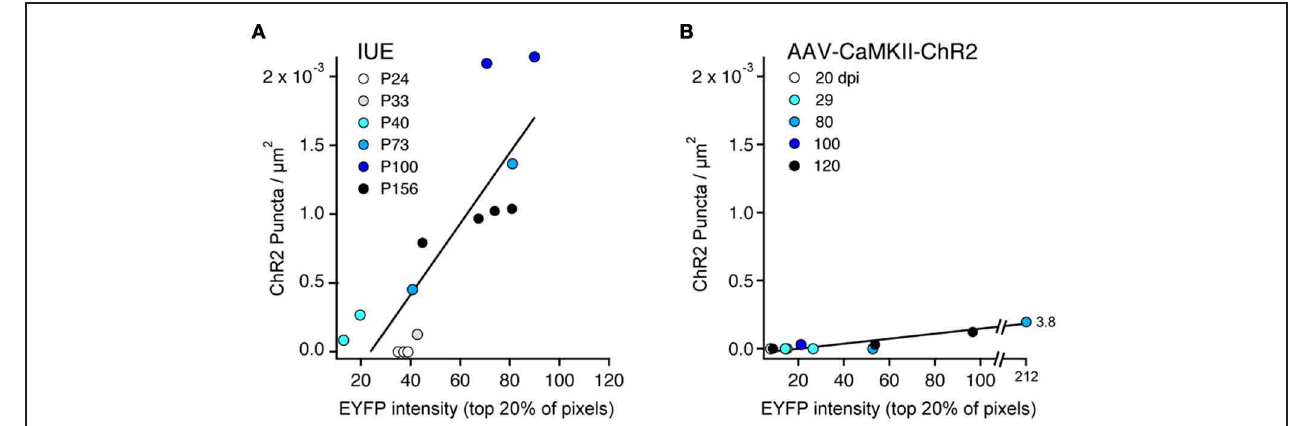
FIGURE 8 | ChR2 puncta density correlates with ChR2 expression level. (A) , IUE cases. Each point represents one animal, analyzed in L2/3 at region of maximal S1 expression. Color indicates age. ChR2 expression is estimated from EYFP intensity, defined as the mean brightness value (range: 0–255) for